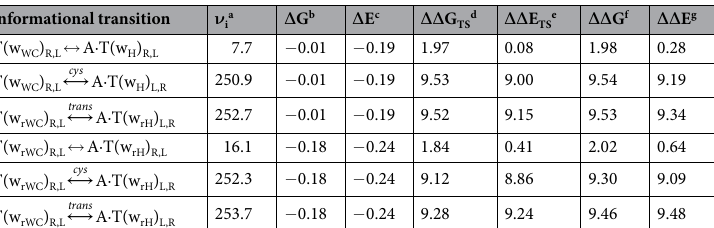
Table 1. Energetic characteristics (in kcal∙mol − 1 ) of the discovered conformational transitions of the four biologically important А·Т DNA bps obtained at the MP2/aug-cc-pVDZ//B3LYP/6-311 ++ G(d,p) level of theory in the continuum with ε = 4 (see Fig. 1). a Imaginary frequency at the TS of the conformational transition, cm − 1 . b The Gibbs free energy of the product relatively the reactant of the conformational transition (T = 298.15 K). c The electronic energy of the product relatively the reactant of the conformational transition. d The Gibbs free energy barrier for the forward conformational transition. e The electronic energy barrier for the forward conformational transition. f The Gibbs free energy barrier for the reverse conformational transition. g The electronic energy barrier for the reverse conformational